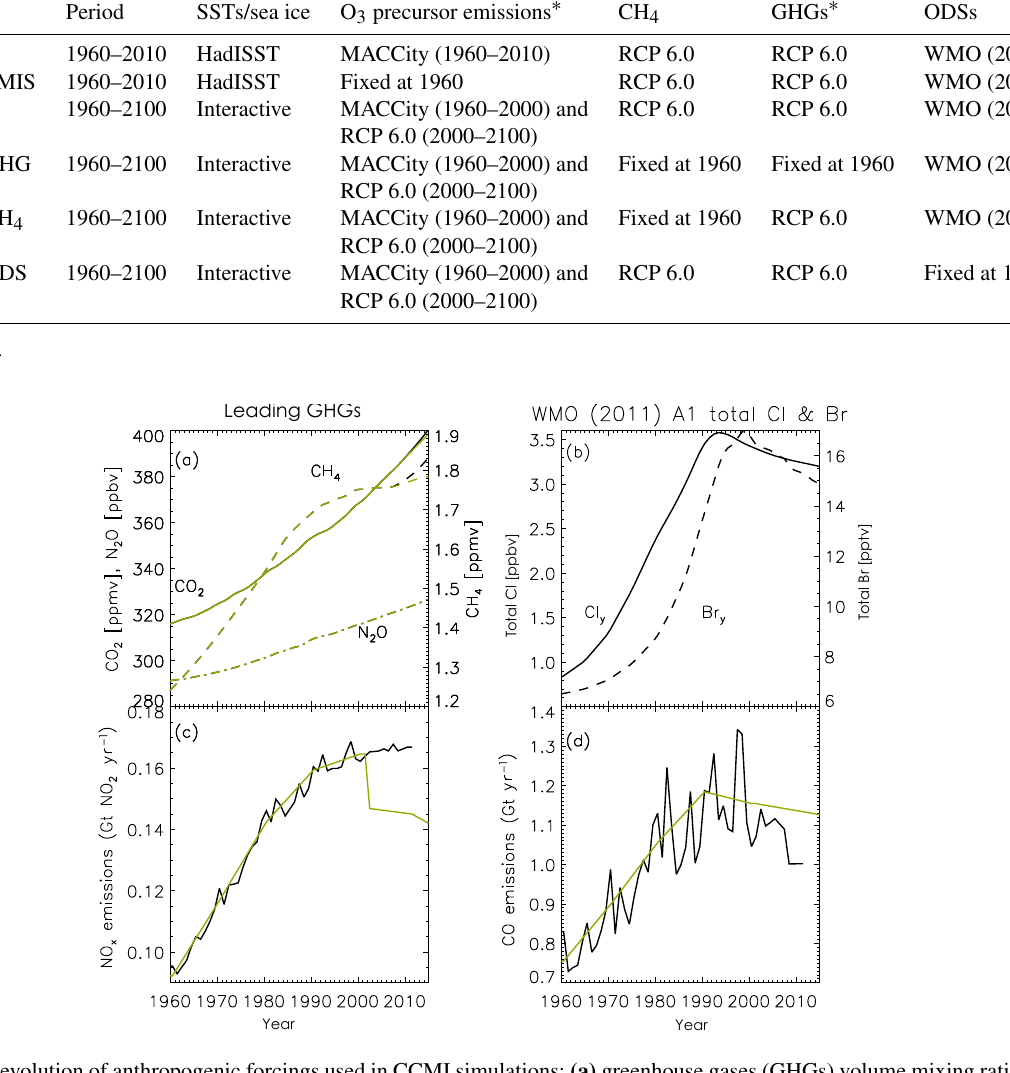
CO 2 , N 2 O, Cl y , and Br y , and the surface emissions of NO x and CO are displayed in Fig.